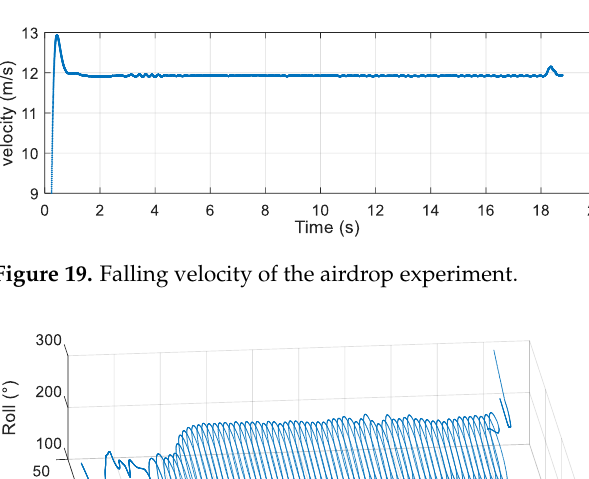
Figure 18. Scanning angle of the airdrop experiment.